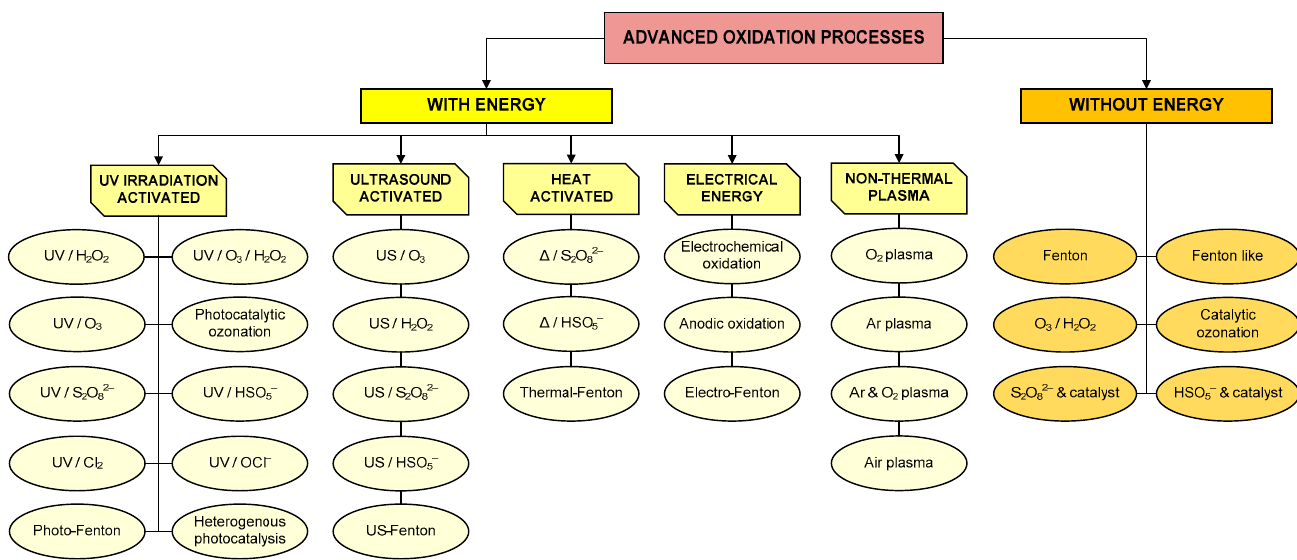
Figure 3. The main types of advanced oxidation processes.